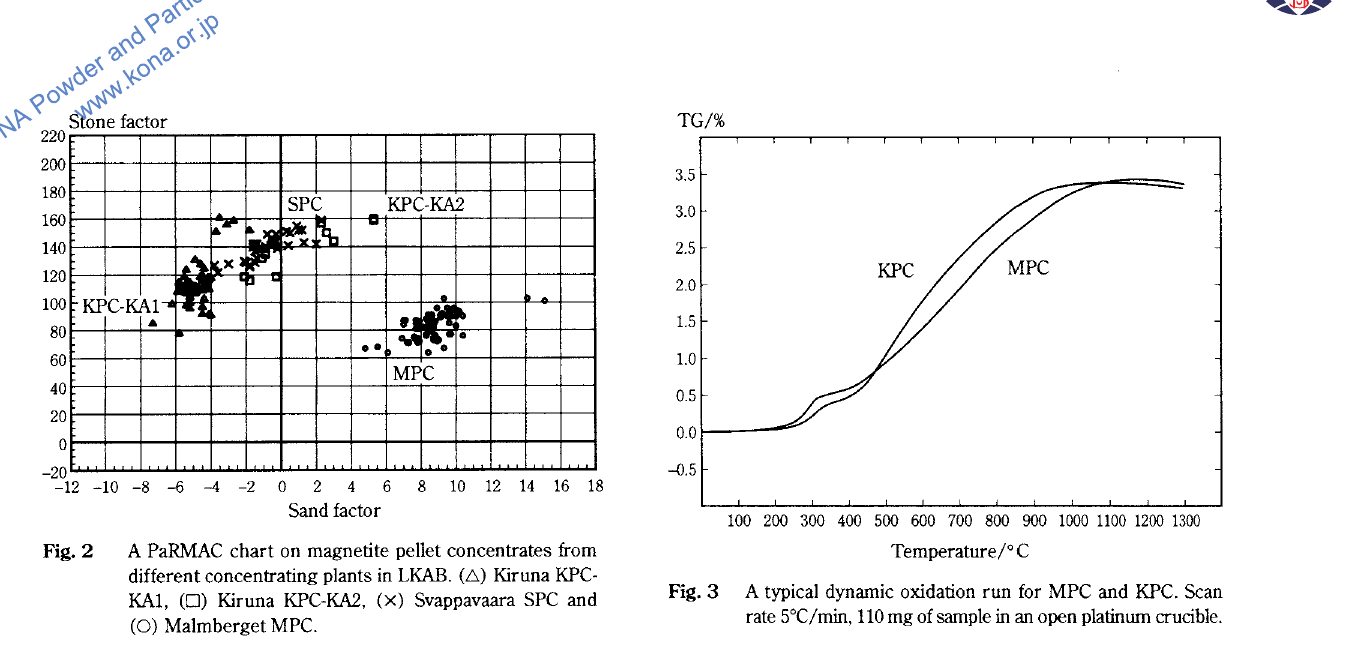
Fig. 3 A typical dynamic oxidation run for MPC and KPC. Scan rate 5°C/min, 110 mg of sample in an open platinum crucible.